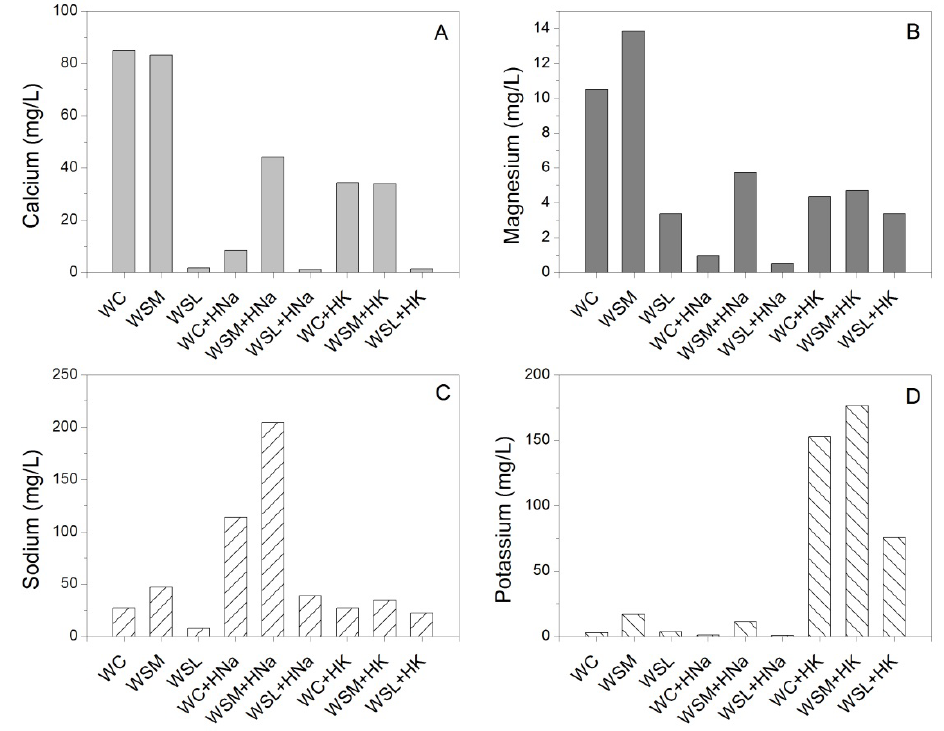
Figure 6. Cations comparison of the types of waters before and after swelling process. ( A ) Calcium, ( B ) Magnesium, ( C ) Sodium, and ( D ) Potassium. ( B ) Magnesium, ( C ) Sodium, and ( D )